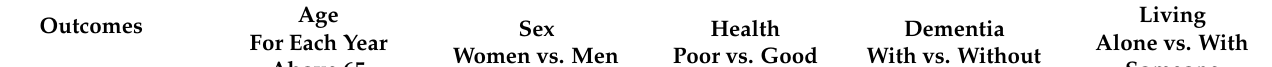
Table 3. Estimated odds-ratios (95% CI in the parentheses) from binary logistic regression 1 . Covariates Age Sex Health Dementia For Each Year Women vs. Men Poor vs. Good With vs. Without Above 65